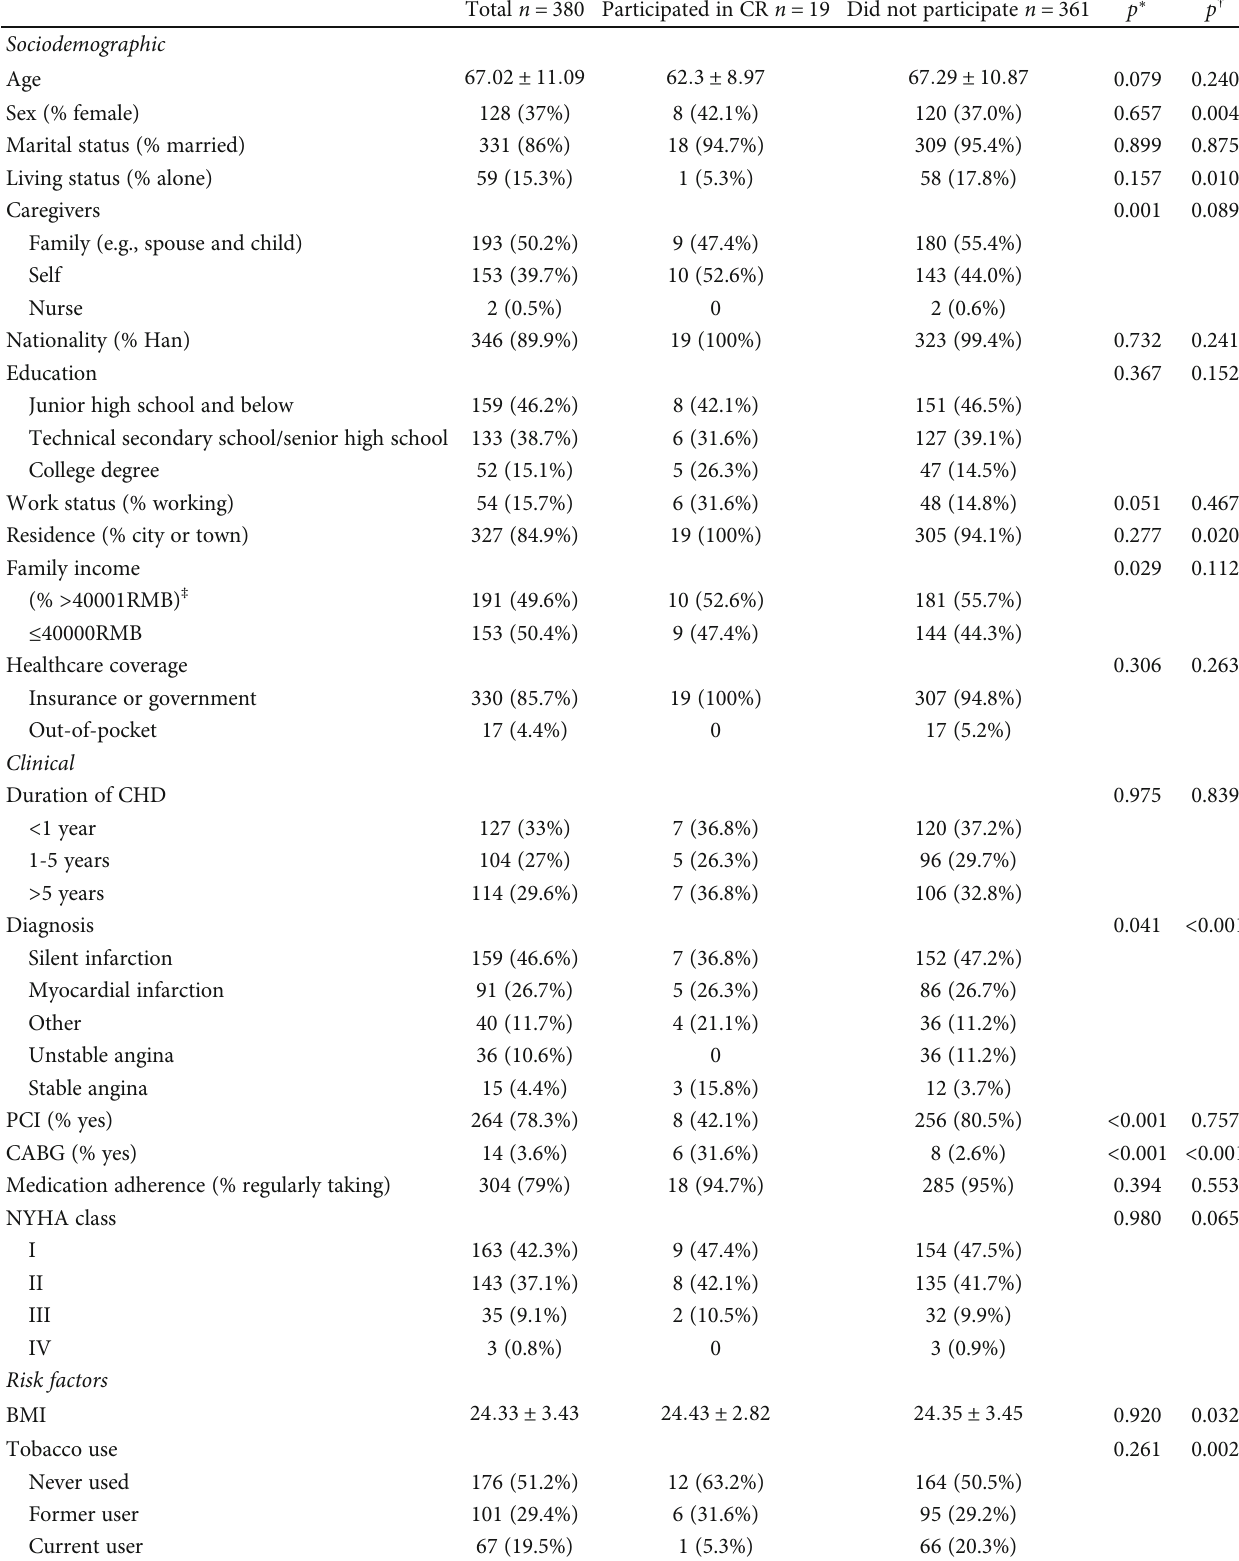
Table 1: Sociodemographic and clinical characteristics of study participants by CR participation, and association with total CRBS